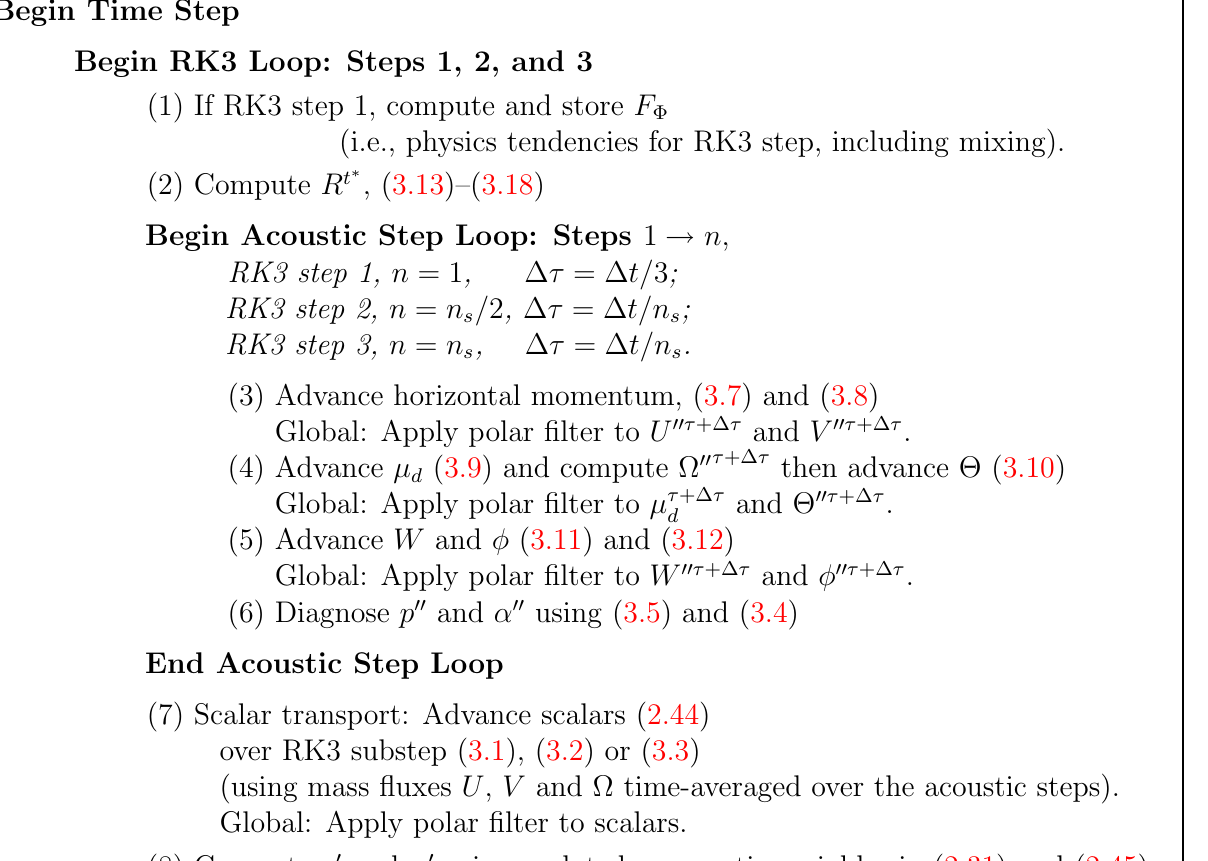
is the ratio of the RK3 time step to s